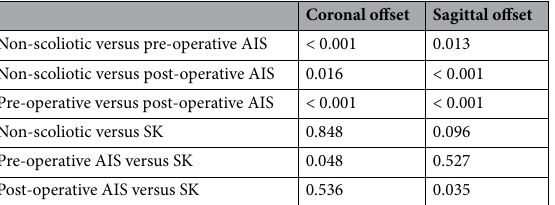
Table 3. The statistical significance between the measures of coronal and sagittal offset in the non-scoliotic, scoliotic and SK groups.